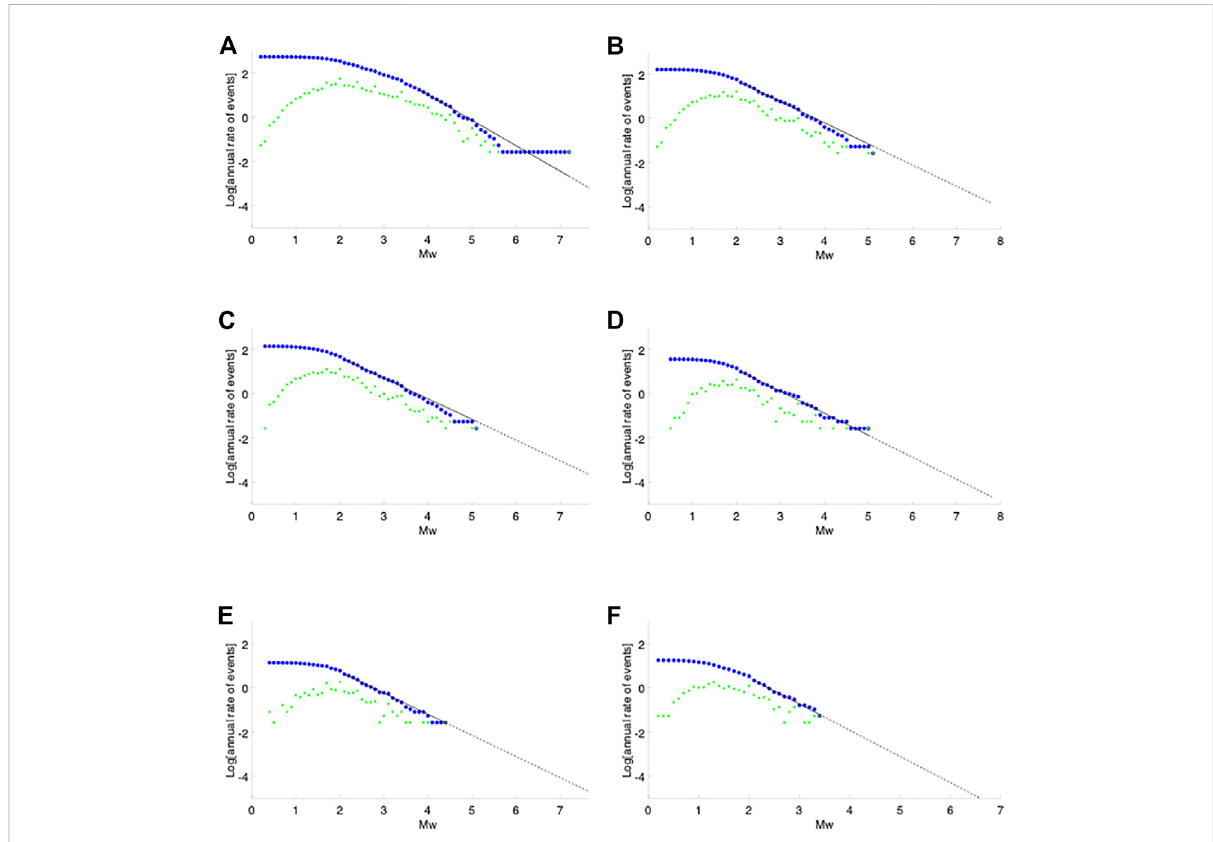
FIGURE 6 Thefrequency-magnituderelationforallearthquakesrecordedbetween1983and2020,within (A) RA; (B) NCA; (C) DST; (D) CTF; (E) OFZ(S); (F) OFZ (N). Dashed parts are extrapolations. Note that the y -axis marks the annual rate of seismicity, and not the total number of events. The tectonic zones of sub-plots c – f are presented in Figure 5.